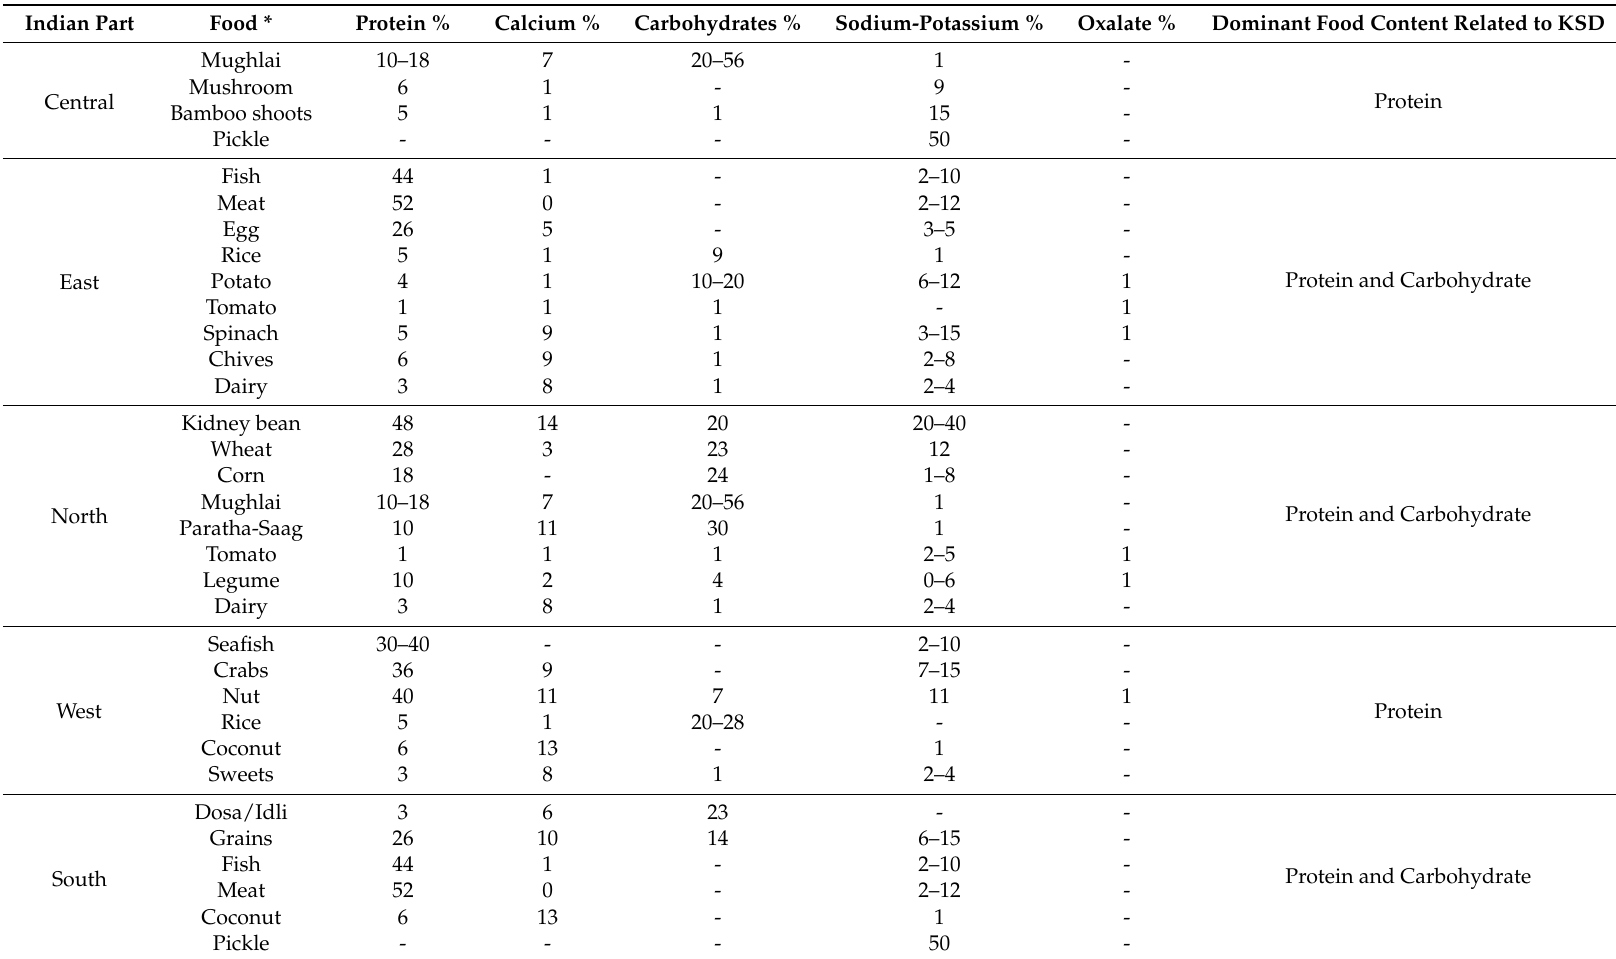
Table 2. Different geographic regions and food habits of